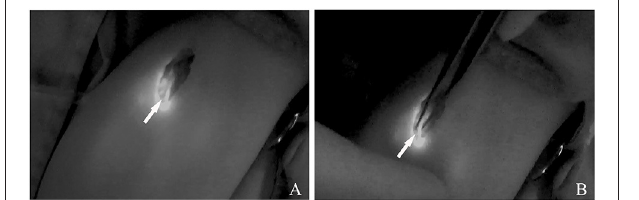
TABLE 1 | Characteristics and outcomes of